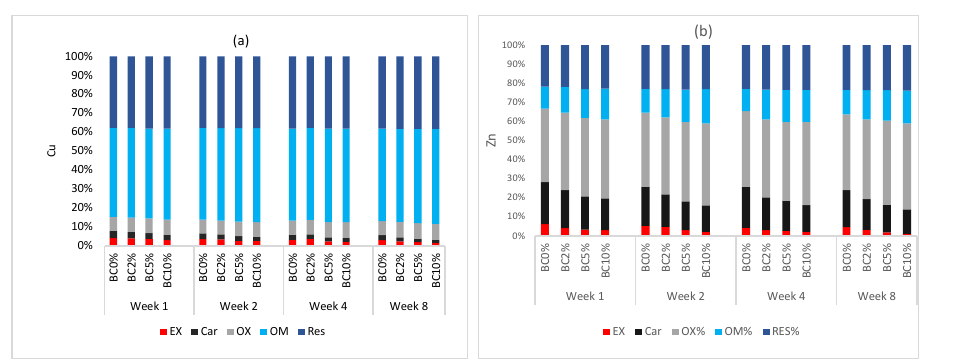
Figure 6. The chemical fraction of Cu (a), Zn (b) from sequential extraction in DC samples with different ratios of CW biochar Distribution of Chemical Fractions at different incubation times